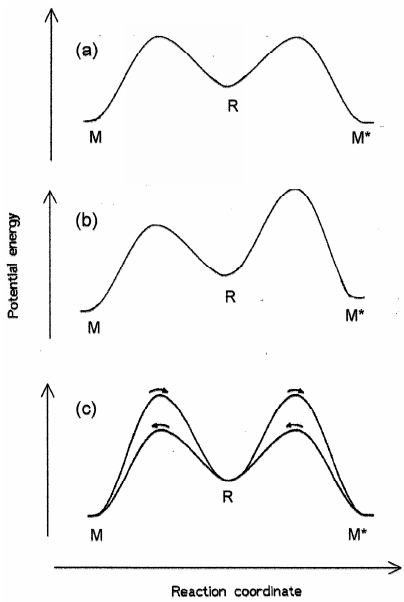
Figure 2. Potential energy profiles for the formation of a chiral molecule M or its enantiomer M* starting from an achiral precursor R. ( a ) In the absence of any chiral influence. ( b ) In the presence of a truly chiral influence. ( c ) In the presence of a falsely chiral influence and illustrating the principle of enantiomeric microscopic reversibility. Adapted from [15].